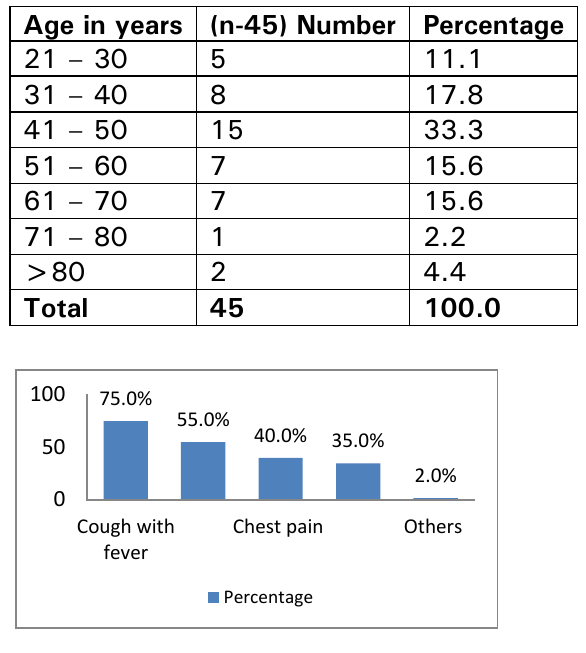
Table 1: Distribution of age groups in